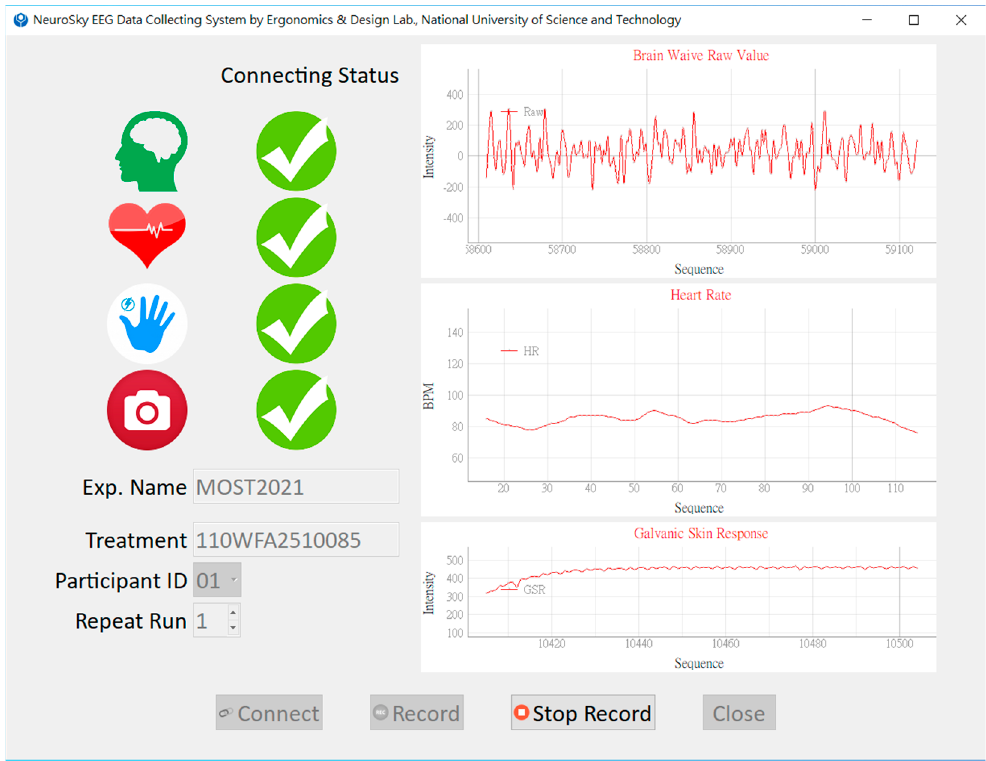
Figure 3. The biometrical sensor, devices, and development board used in this study. The total cost of these devices was about USD 800, which is a significant cost saving when compared with a medical-grade system. Table 3. Libraries used for the biofeedback system developed in this study.